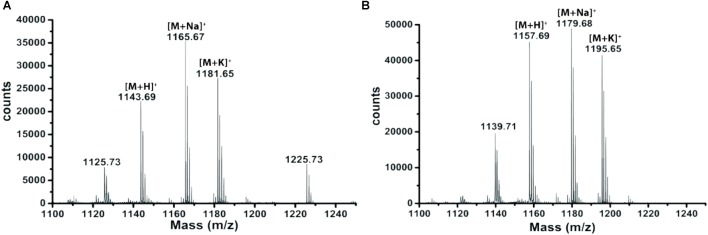
MALDI-MS spectra of P1 (A) and P2 (B).